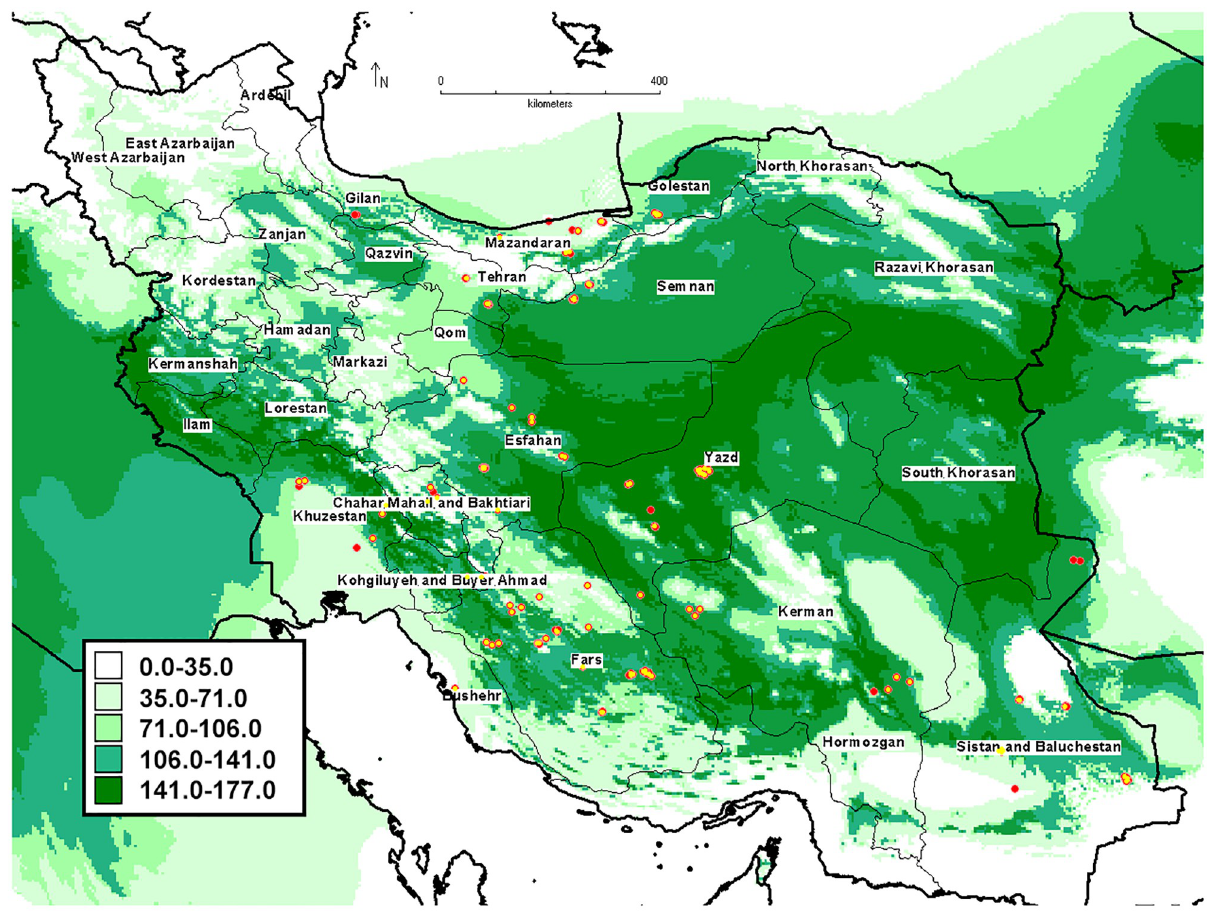
Fig 13. Current spatial distribution of pomegranate in